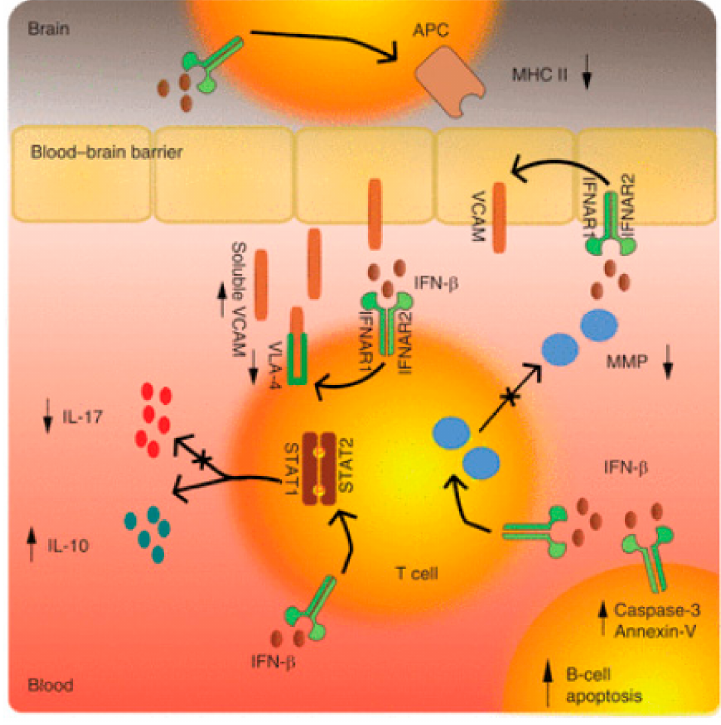
Figure 1. Molecular Mechanisms of Action of Interferon β